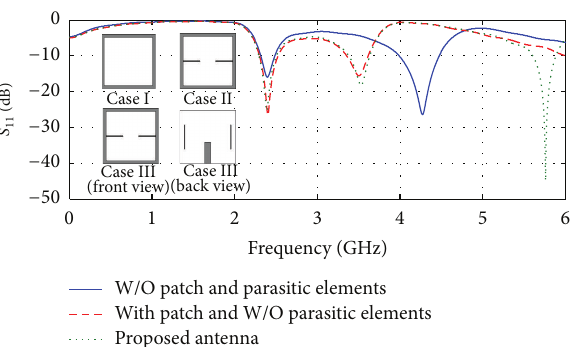
Figure 2: Design procedure of the proposed antenna. Case I: single band, Case II: dual-band, and Case III: triband operation.